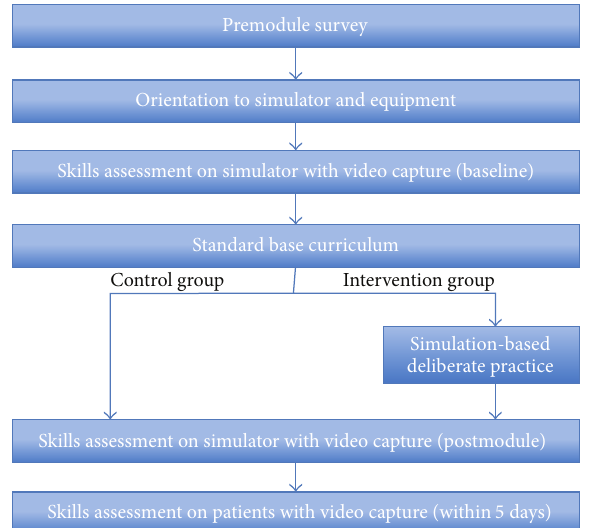
Figure 1: Study flow chart following informed consent and enroll-